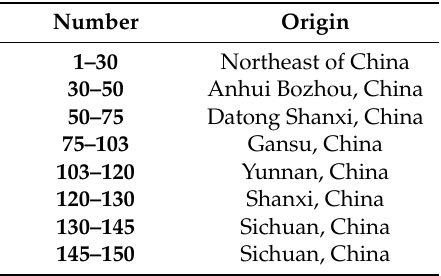
Table 1. Origin of Rhizoma Cimicifugae.